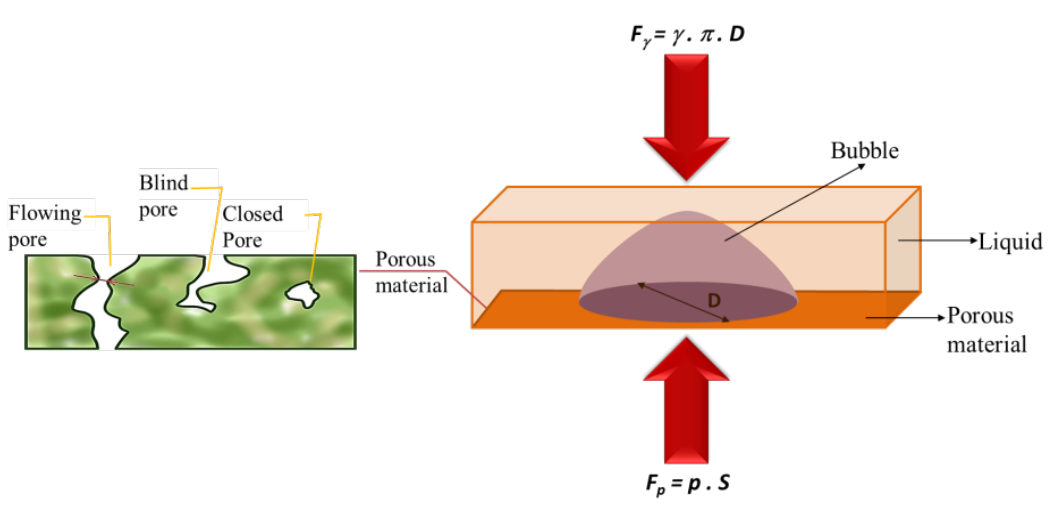
Figure 3. Schematic diagram of pore flow and forces acting on a pore.